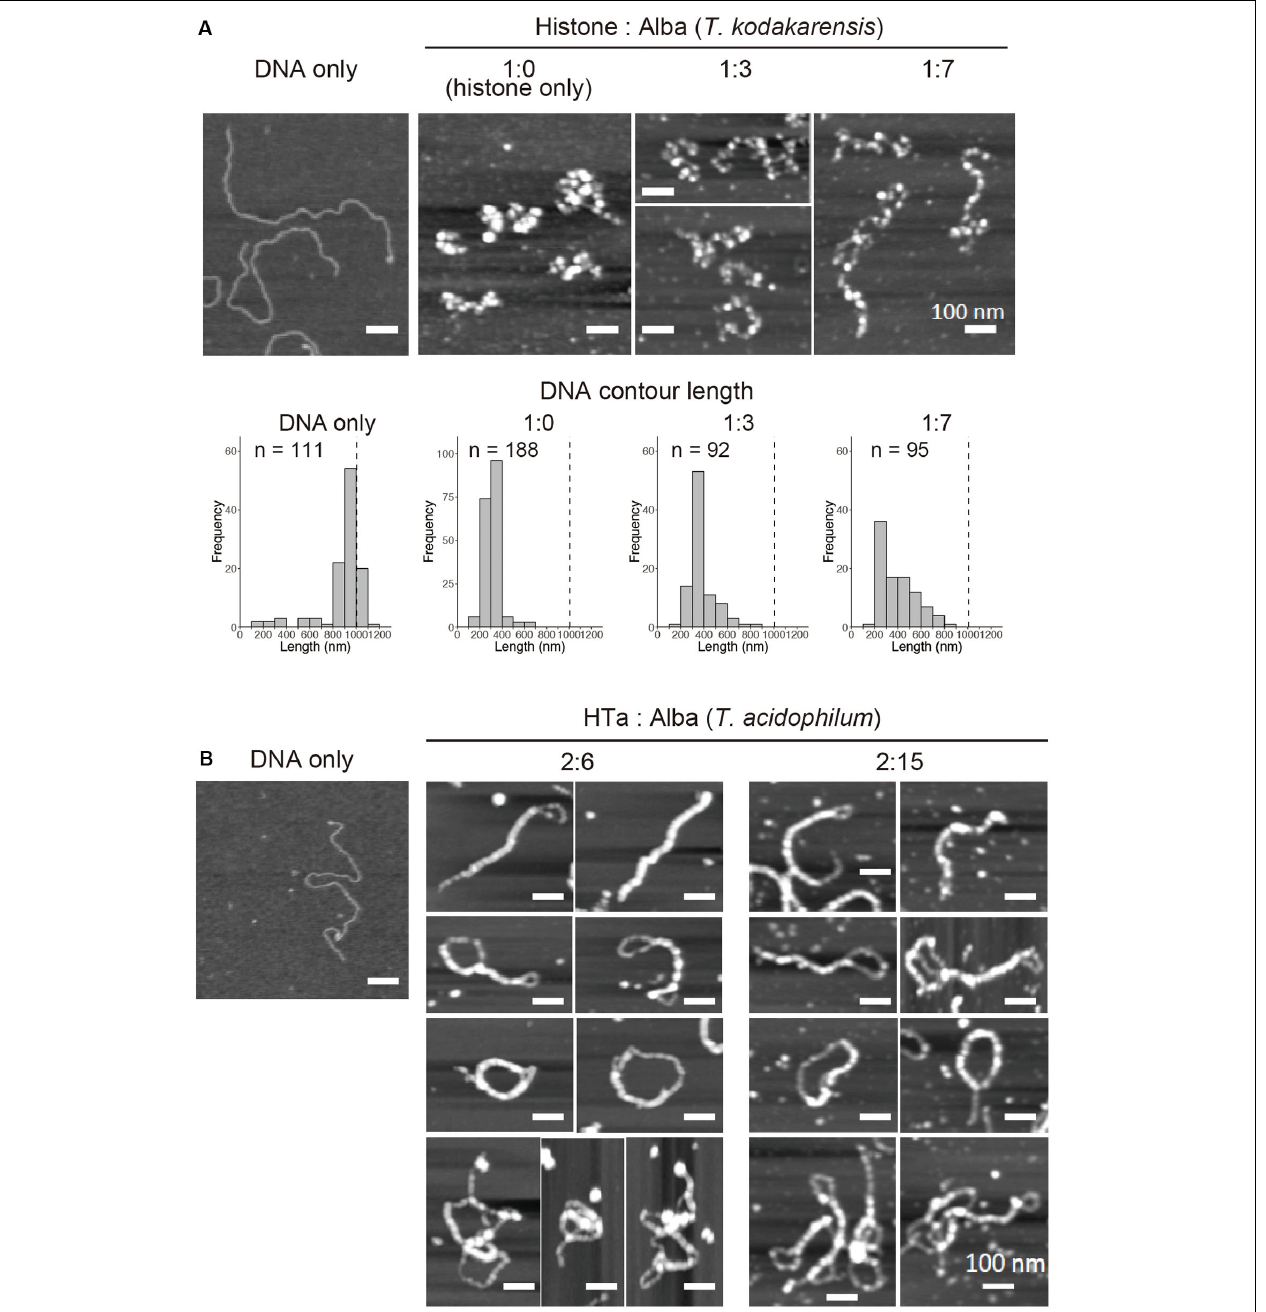
FIGURE 6 | In vitro reconstitution using a combination of archaeal proteins. Chromatin structures were reconstituted on a linear 3-kb plasmid using recombinant proteins at varying Alba concentrations. (A) AFM images showing reconstitution using histone and Alba from T. kodakarensis . Histograms below the AFM images show the contour DNA length in each condition. Dashed line indicates the theoretical length of a 3-kb unbound DNA. (B) AFM images showing reconstitution using HTa and Alba from T. acidophilum . Scale bars: 100 nm. Note that histograms are not shown in (B) because of the inability to accurately measure the DNA contour length due to a high degree of folding or joining of the fiber